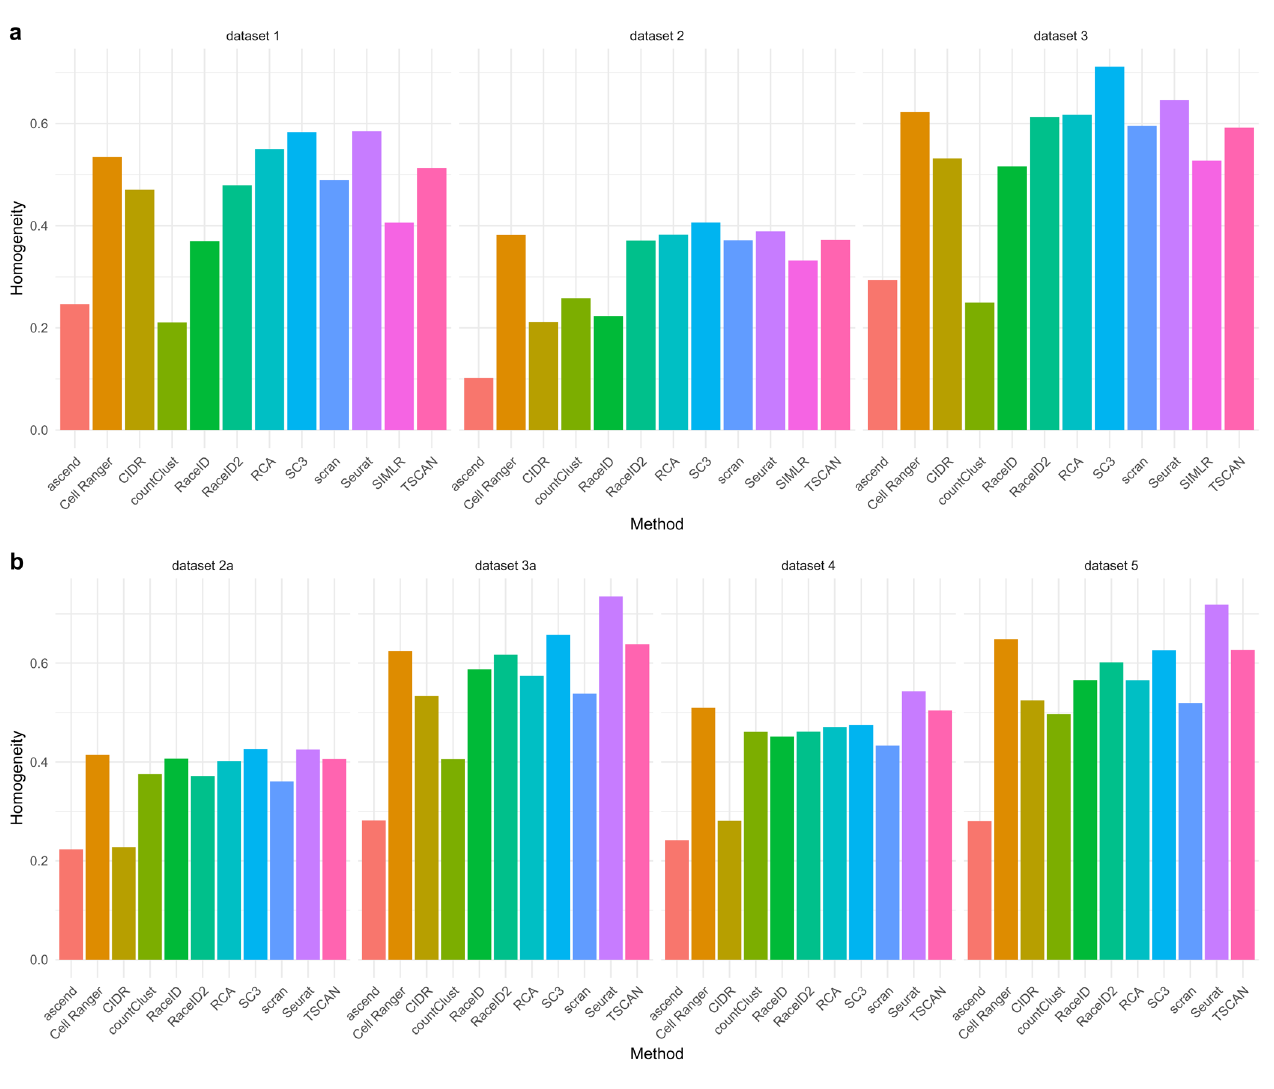
Figure 3. Homogeneity of clusters with regards to the inferred cell labeling for each method and each dataset. Different datasets are indicated by transparency. ( a ) First evaluation with methods available in R 3.4.3. ( b ) Second evaluation with methods available in R 3.5.0.